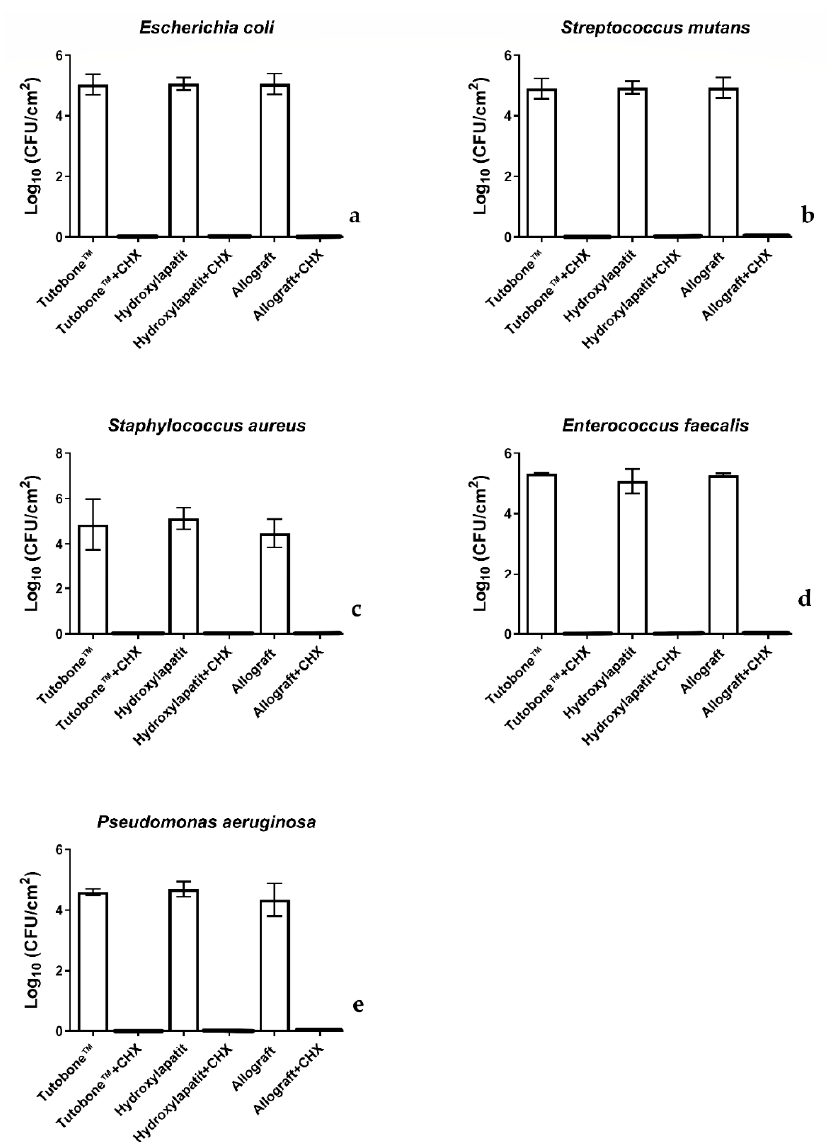
Figure 3. Boxplots demonstrating the colony-forming units (CFUs) of E. coli , S. aureus , S. mutans, E. faecalis and P. aeruginosa on the tested bone graft materials with or without the application of 0.2% CHX solution. As shown in diagram, no bacterial colonies were detected after treatment with 0.2% CHX solution. ( a ) E. coli , ( b ) S. mutans , ( c ) S. aureus , ( d ) E. faecalis and ( e ) P. aeruginosa .